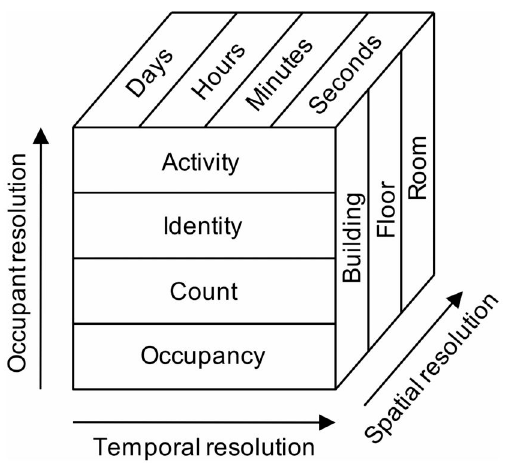
Figure 1. Dimensions of occupancy sensing resolution